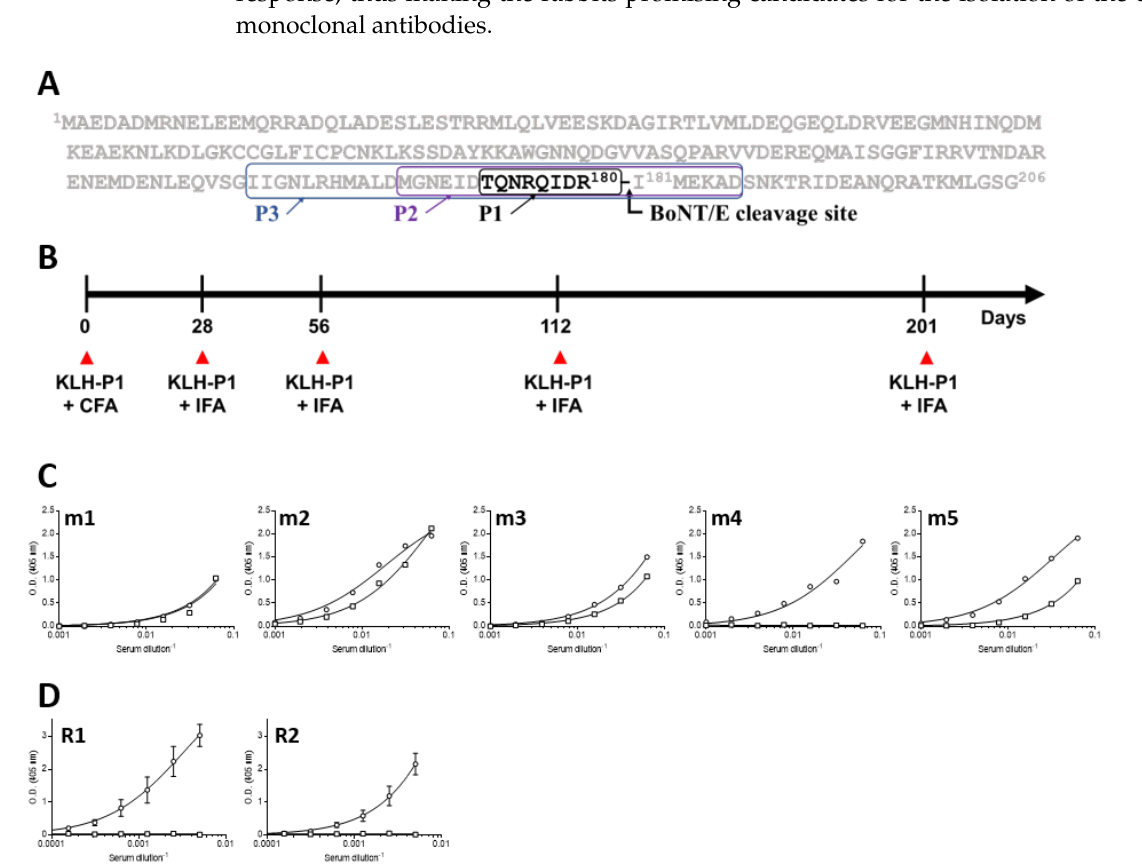
Figure 1. Peptide design, rabbit immunization and antibody serum levels. ( A ) SNAP-25 protein sequence highlighting the BoNT/E cleavage site and the peptides used in this study. ( B ) Animal immunization regimen using KLH-P1 in either CFA (priming) or IFA (boosting). ELISA binding curves of serum of ( C ) immunized mice or ( D ) rabbits against Bio-P1 (circles) or Bio-P2 (squares). Lines represents non-linear regression fit, and ( D ) points are the mean ± STD of duplicates.